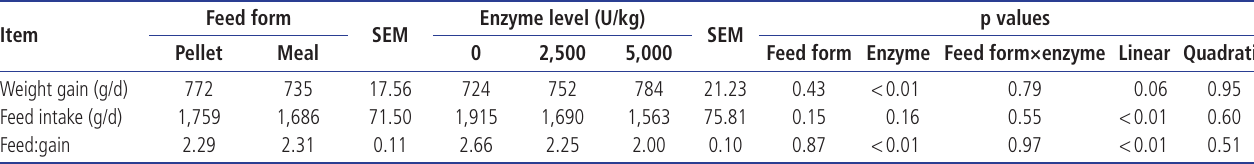
Table 4. Effects of pelleting and xylanase on performance of growing pigs fed wheat-based diets 1)